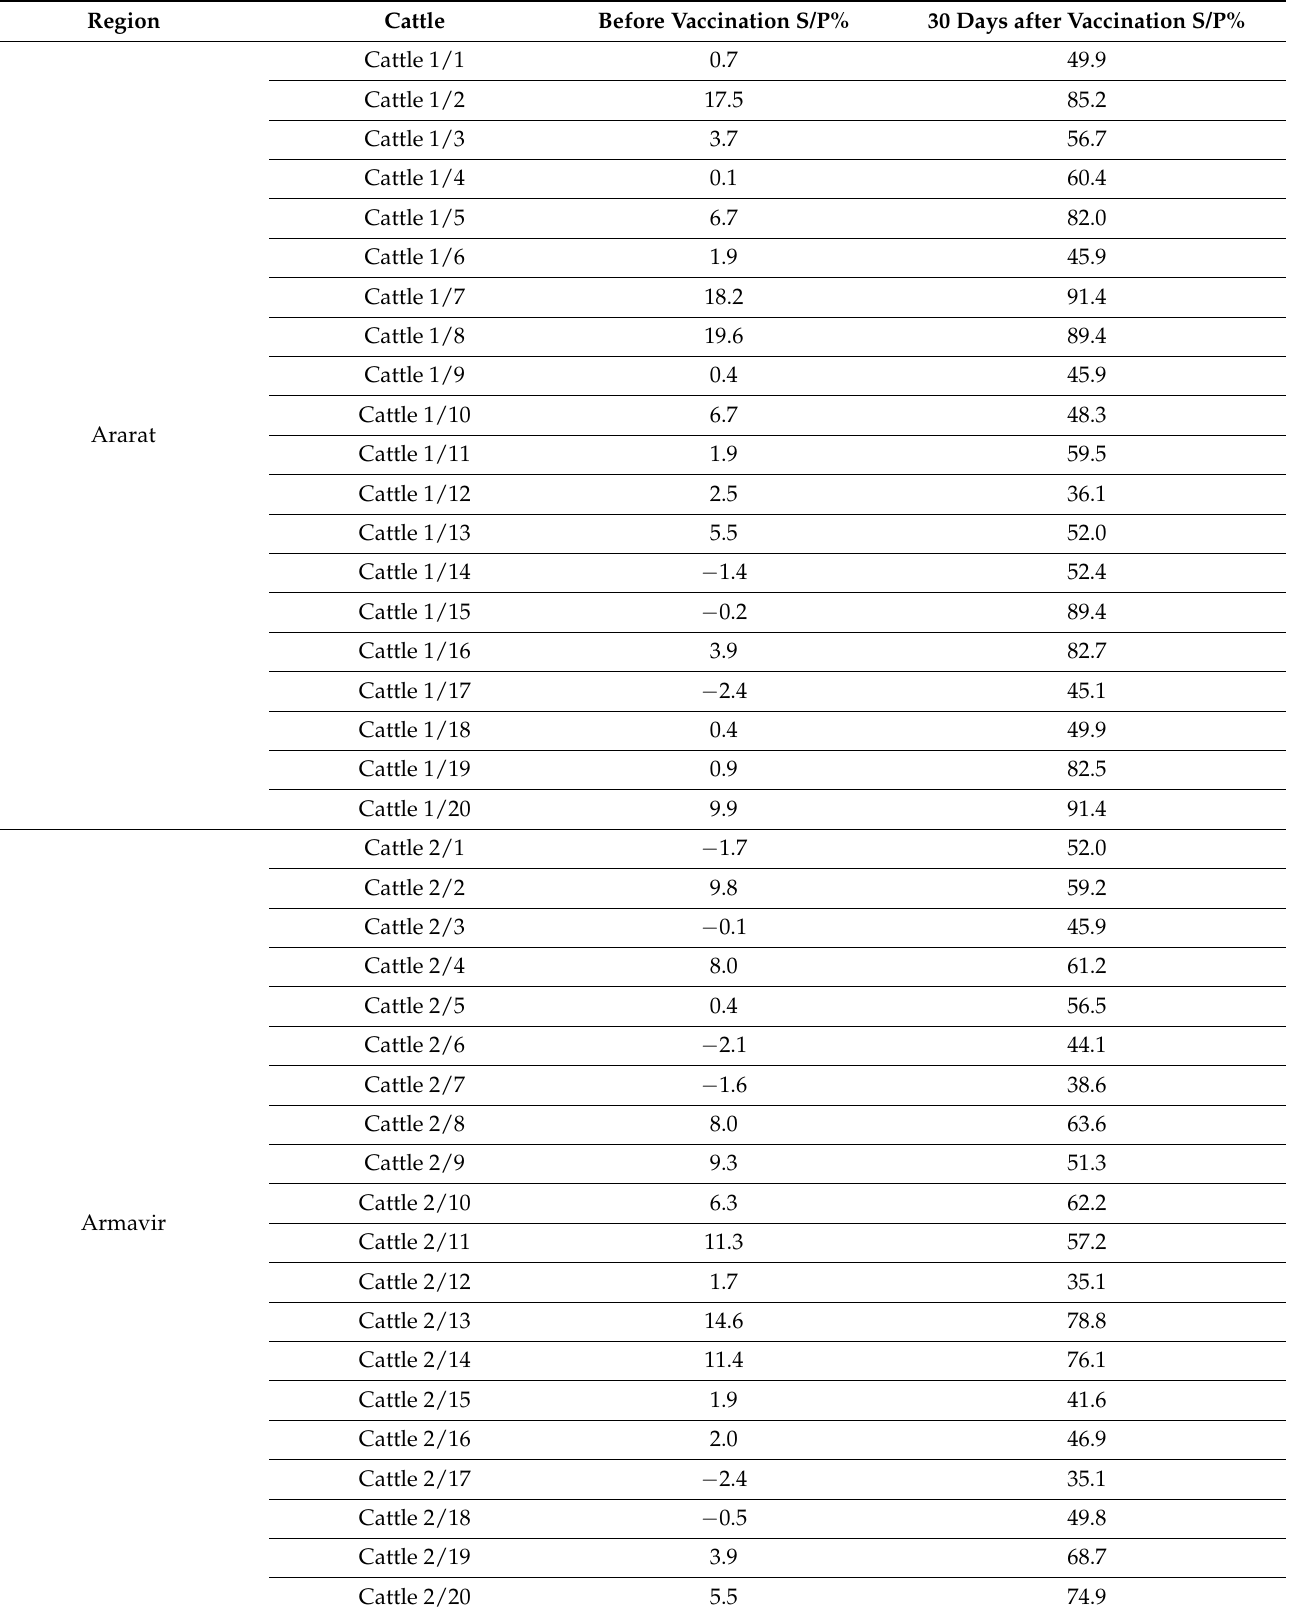
Table 2. Individual seroconversion results of 60 cattle with pre- and 30 days post-vaccination titers. Region Cattle Before Vaccination S/P%